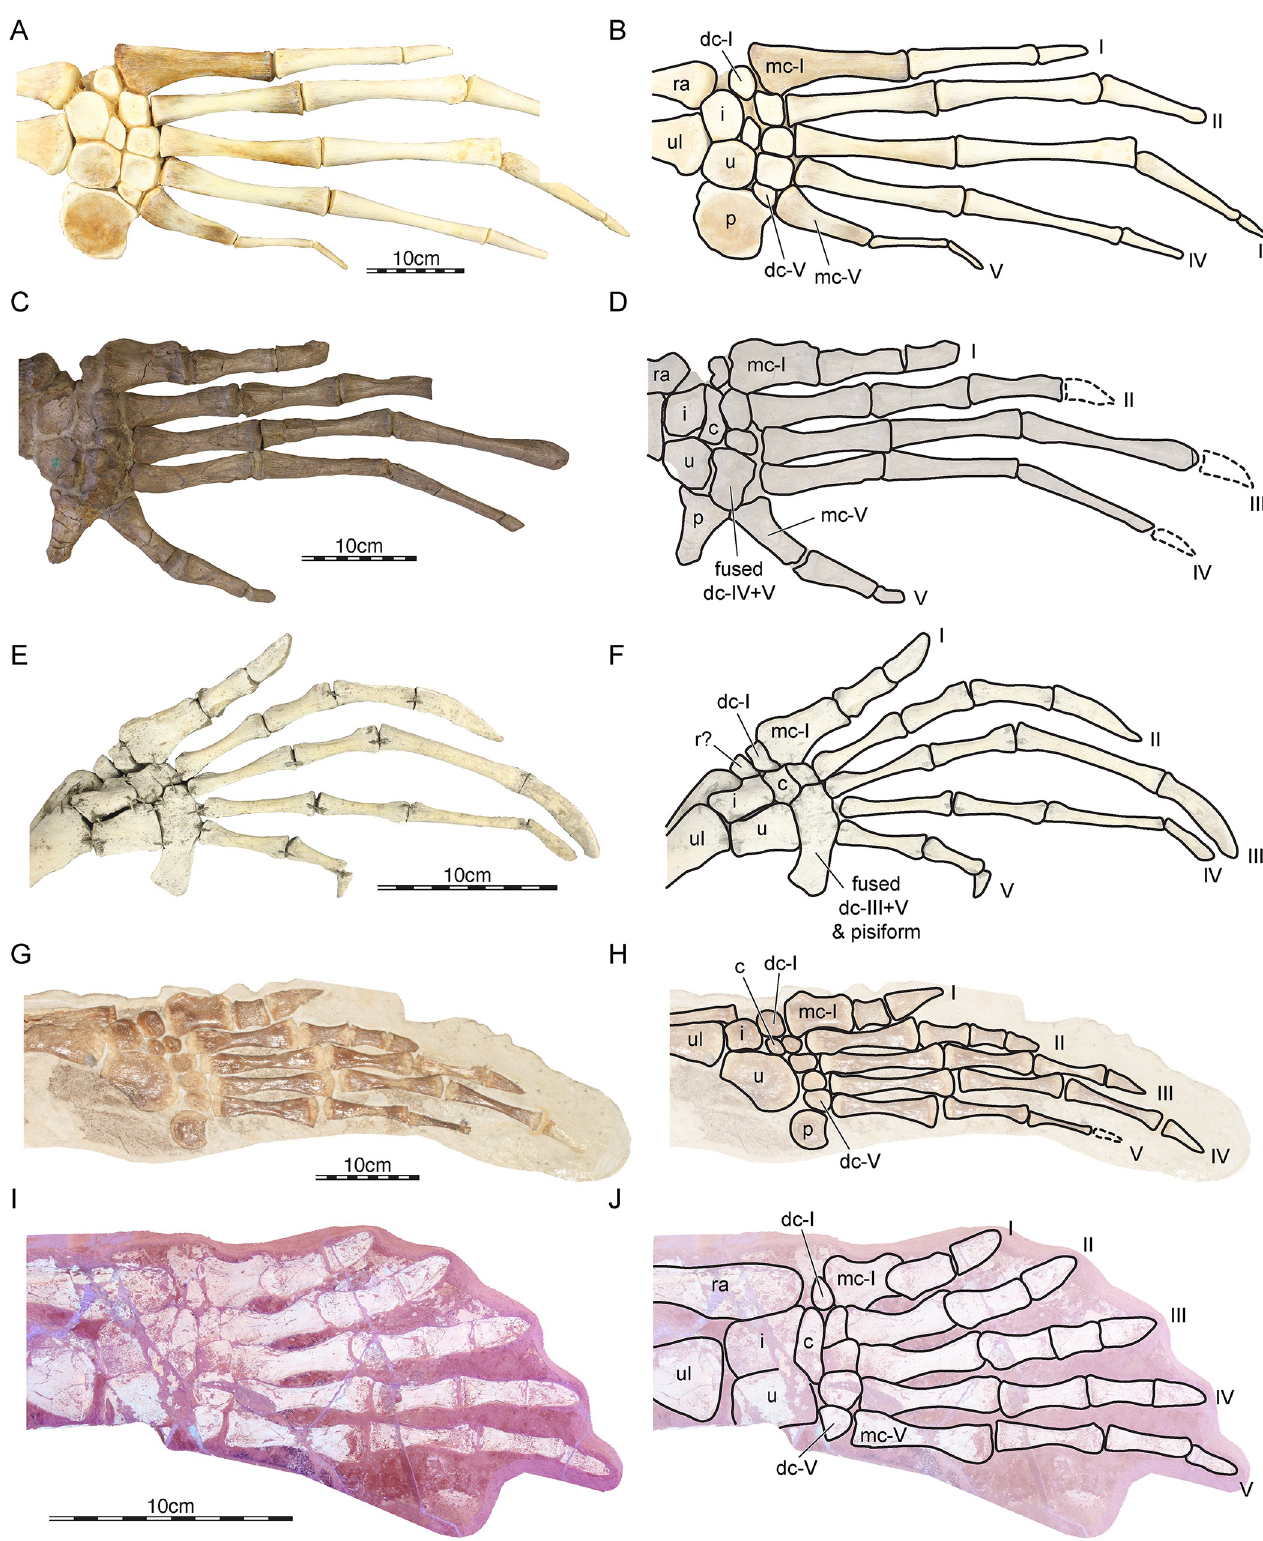
Fig 8. Comparisons of forelimbs of marine adapted turtles. ( A) photograph and (B) line drawing of reflected left flipper of the extant leatherback turtle Dermochelys coriacea (QM J47453) in dorsal view. (C) photograph and (D) line drawing of right flipper of the extinct chelonioid Allopleuron hofmanni